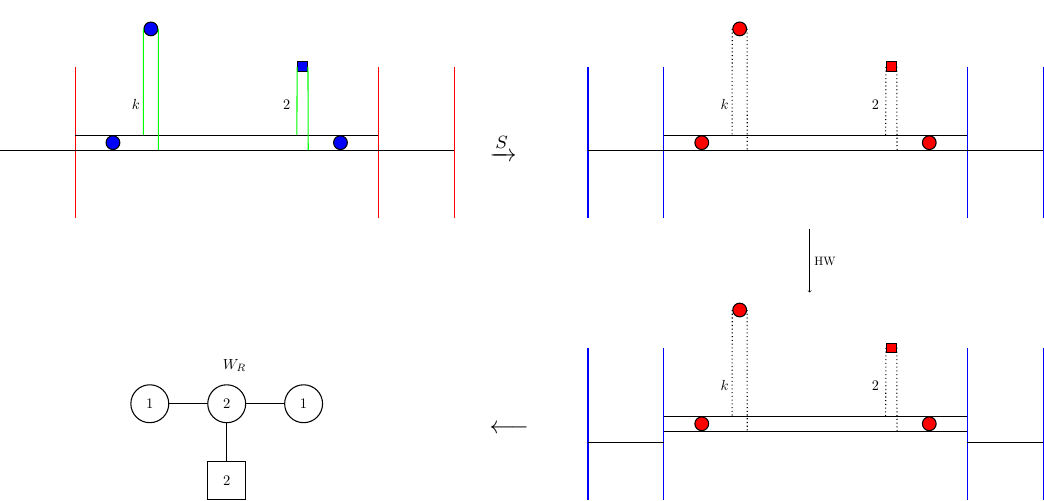
Figure 16 . Type IIB configuration for a vortex defect mapping to the corresponding configuration for a Wilson